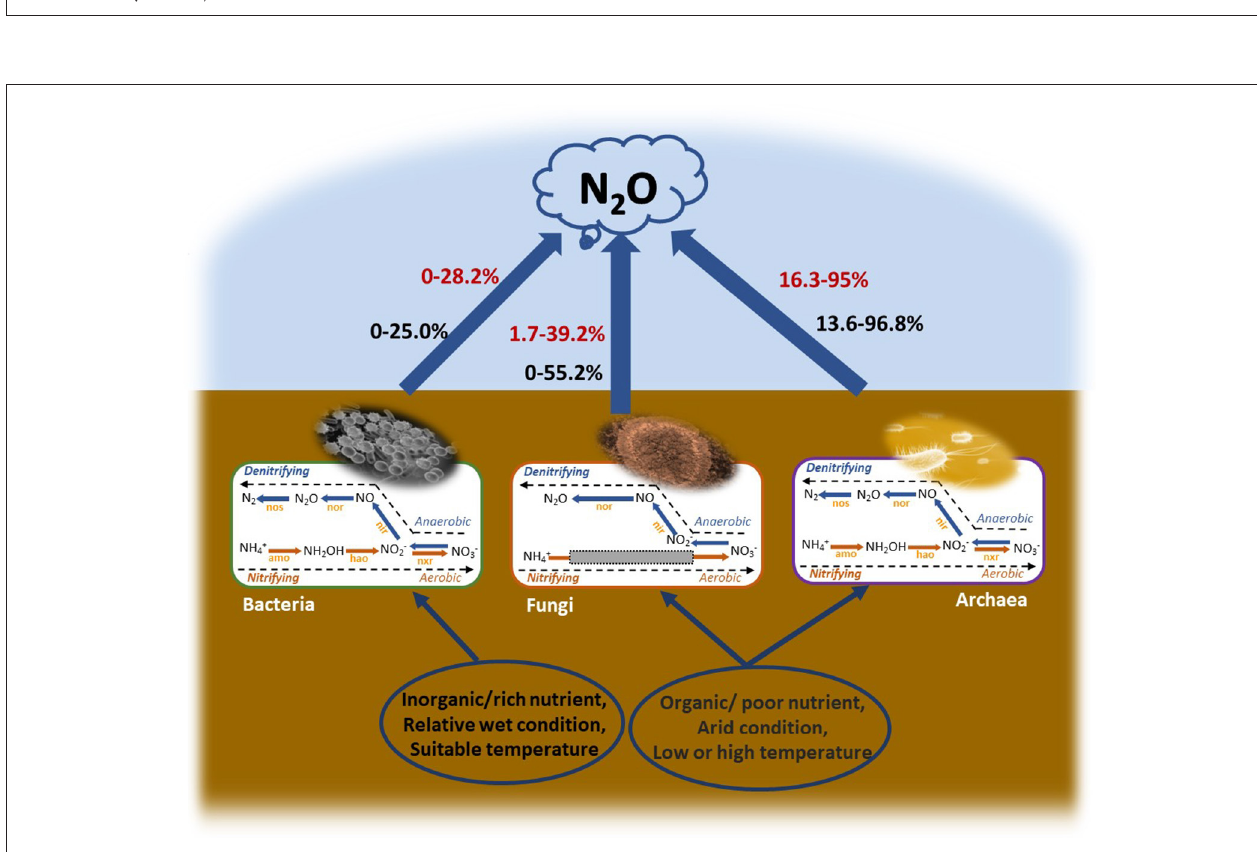
FIGURE 5 | Contribution and mechanisms of bacteria, fungi, and archaea to the N 2 O production potential. The red color of the numbers represents the contribution of BNEA, FNEA, or ANEA to TNEA. The black color of the numbers represents the contribution of BDEA, FDEA, or ADEA to TDEA.